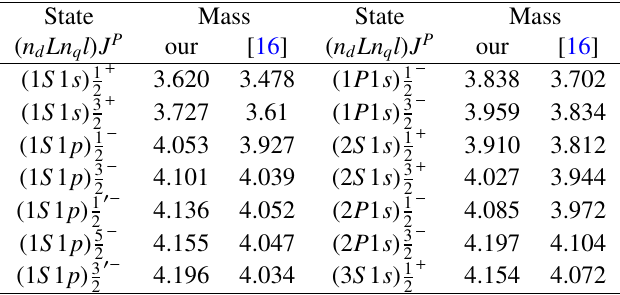
Table 7. Mass spectrum of Ξ cc baryons (in GeV)